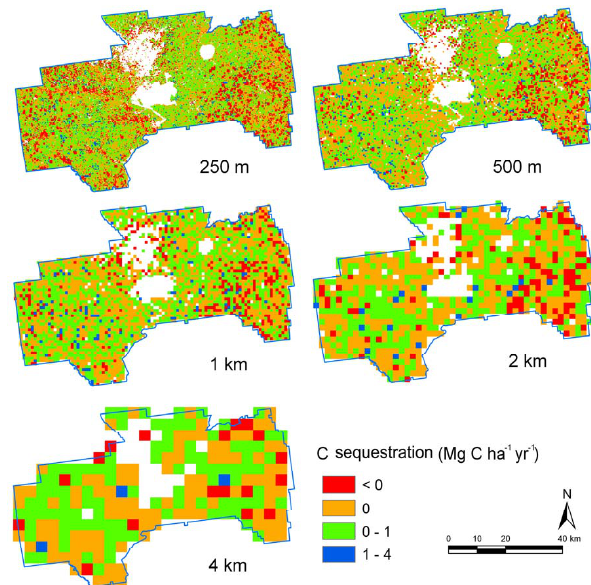
Fig. 6. The distributions of carbon sequestration between 1992 and 2007 for five spatial resolutions. White represents urban/residential areas (mainly Columbus in the central north) and the cantonments in the installation (i.e., two big contiguous areas at the central south and the right). These areas were masked because of lack of input data or proper understanding of the underlying